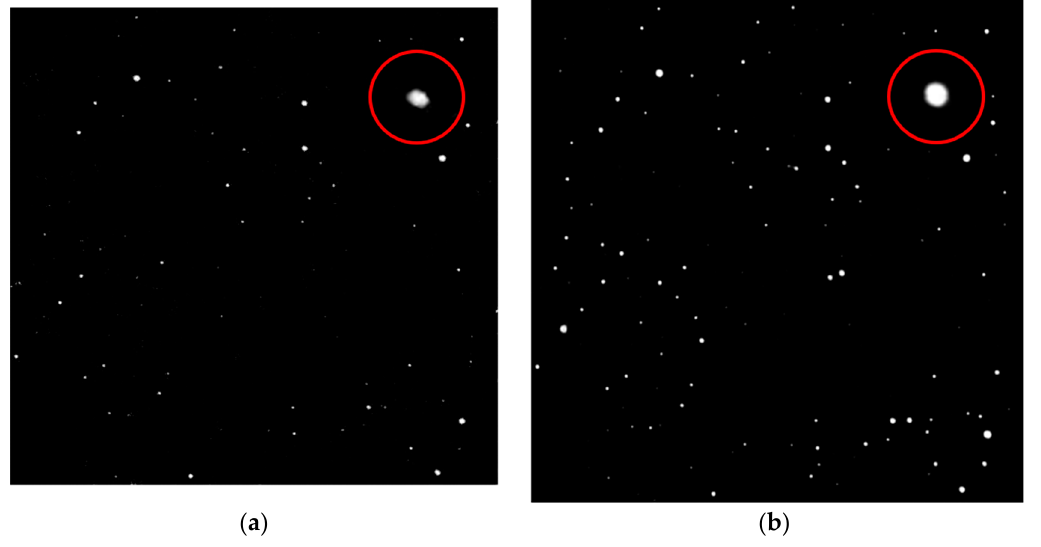
Figure 6. ( a ) The training results after the image with a resolution of 256 × 256 is input into the network; ( b ) the training results after the image with a resolution of 512 × 512 is input into the network.